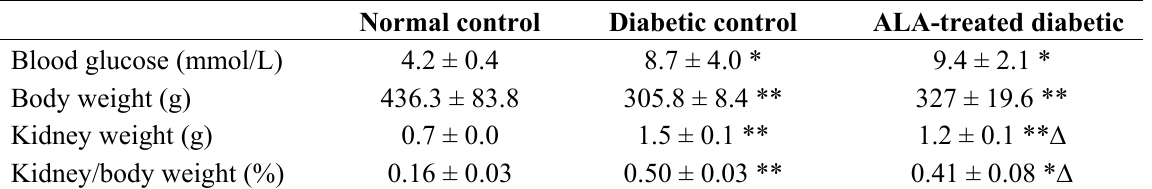
Table 1. Effects of α -lipoic acid on body and kidney weight and blood glucose.